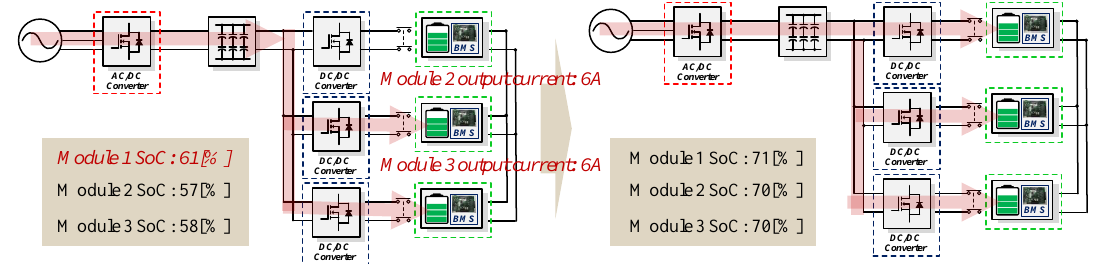
Figure 17. Current flow in charge control according to SoC state.